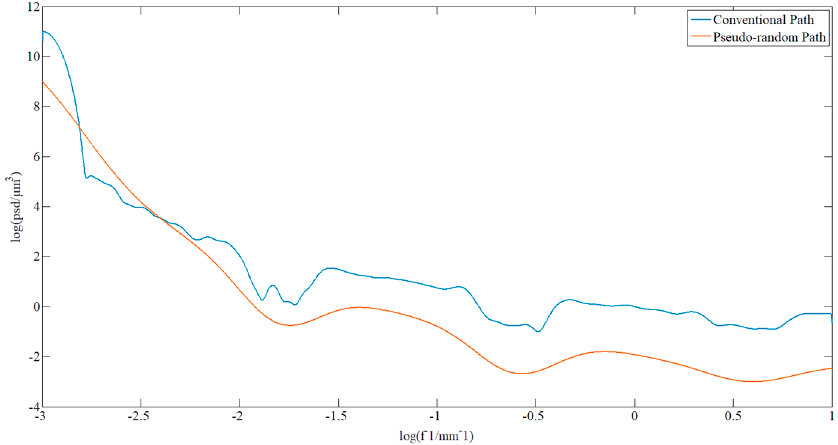
Figure 12. Comparison of the PSD of the sample before and after pseudo-random path polishing.